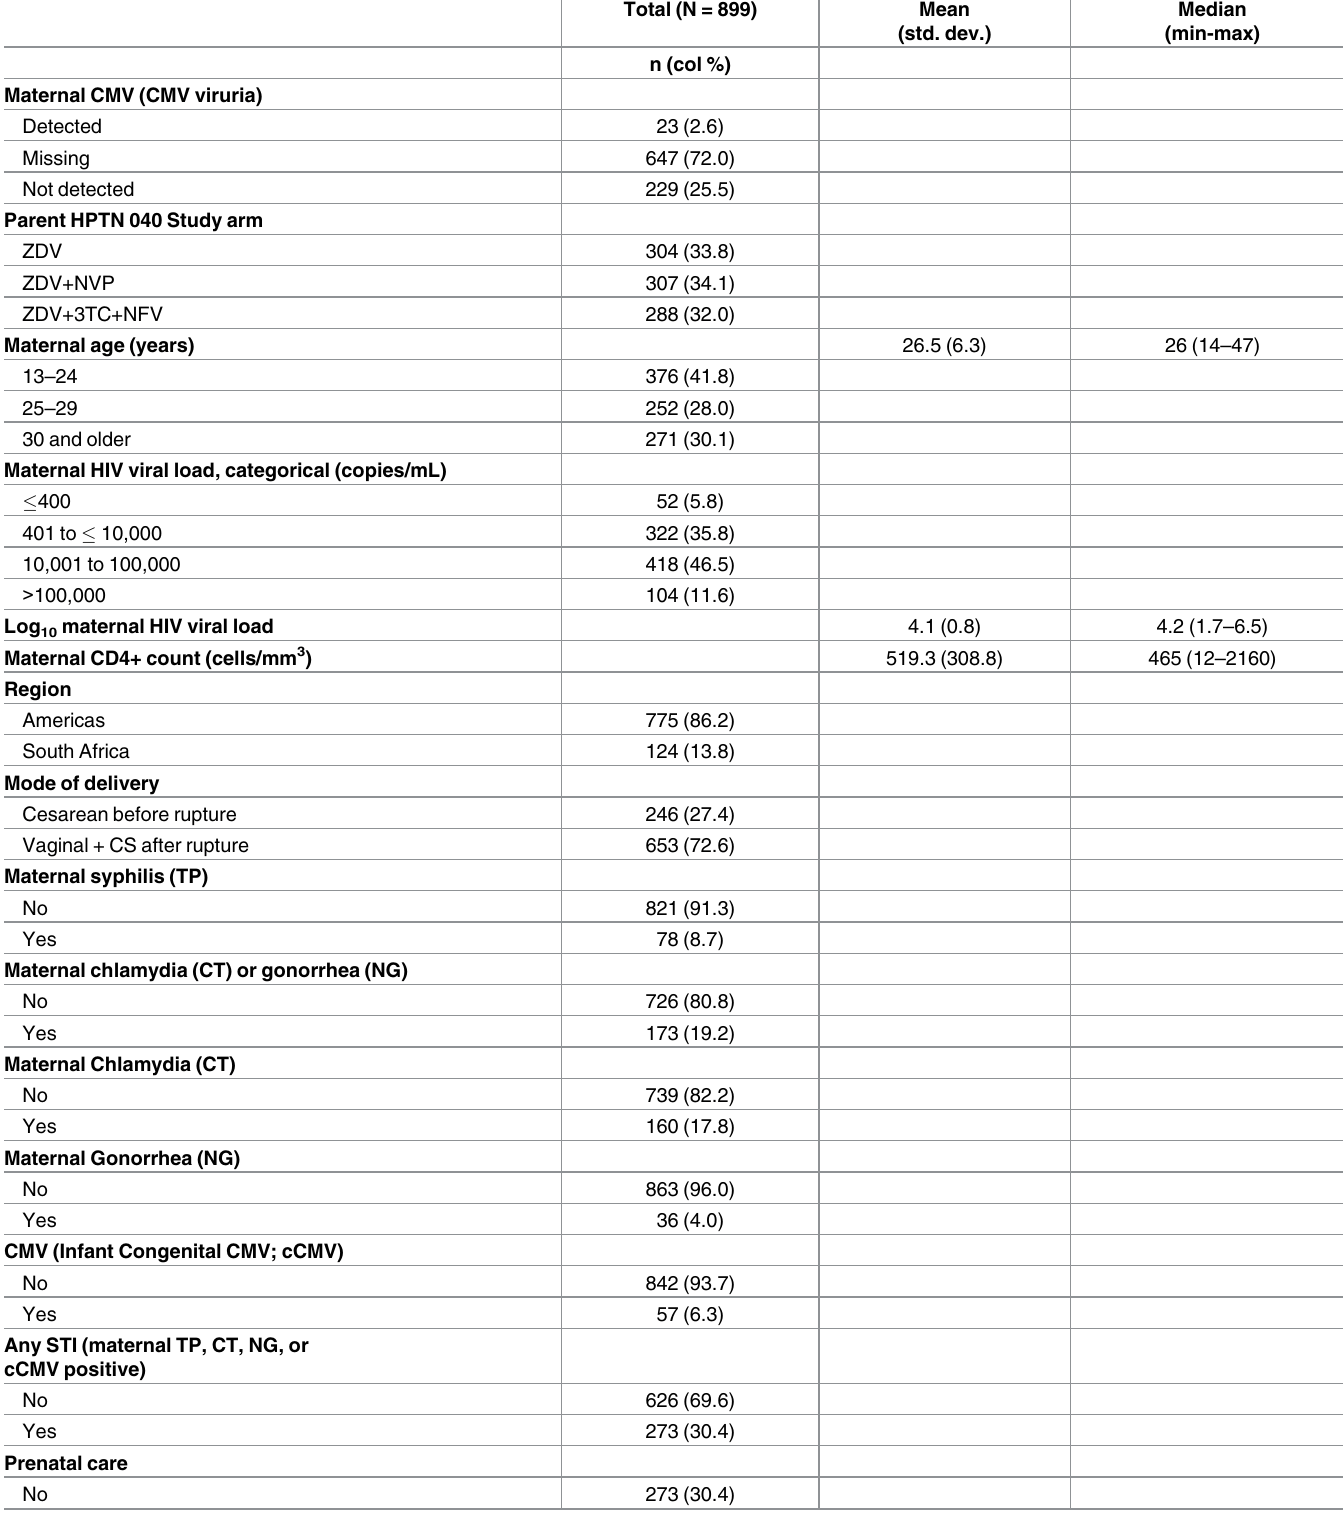
Table 1. Demographic, Baseline, and other characteristics of NICHD HPTN 040 mother-infant pairs.